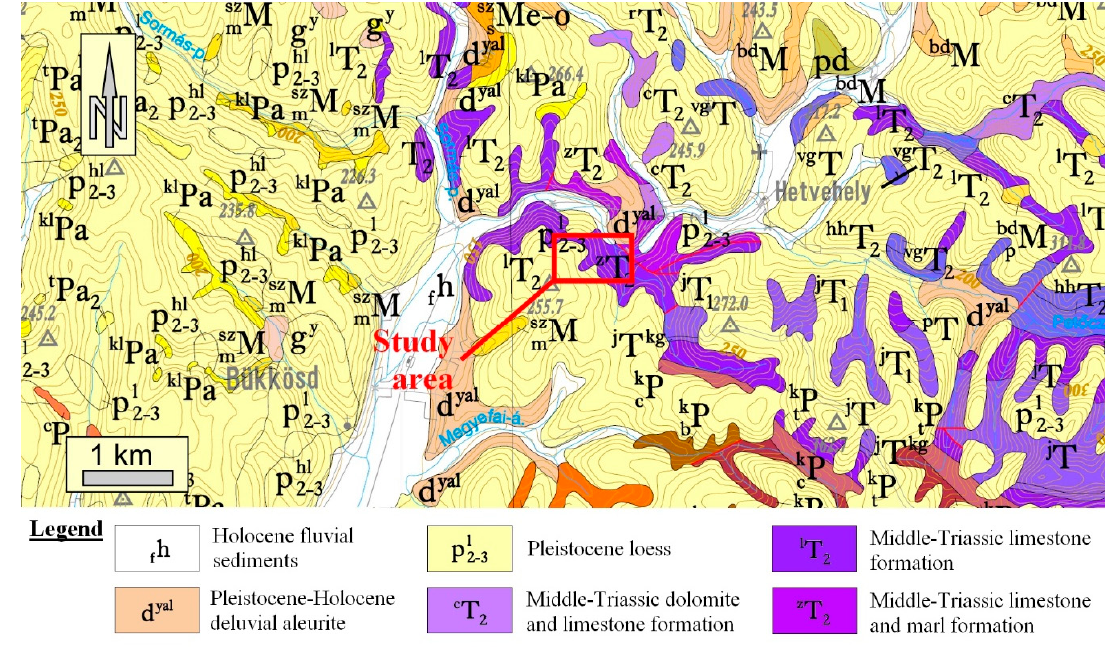
Figure 3. Geological map of the study area and its surroundings. The surveyed area is characterised by Middle Triassic carbonates and younger coverbeds [49].